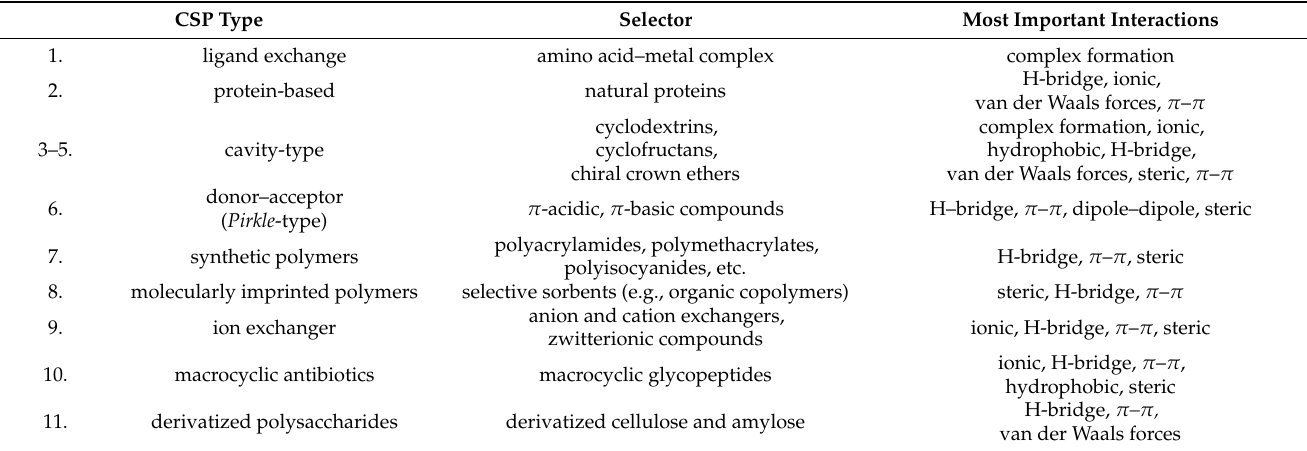
Table 1. Common chiral stationary phases, their selectors, and the most important interactions for chiral recognition. CSP